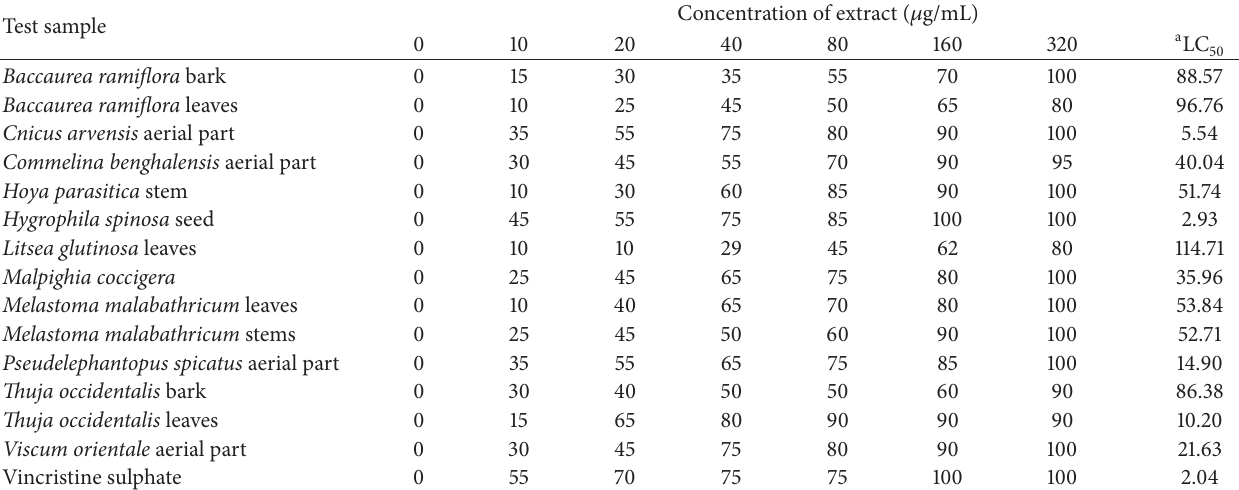
Table 4: Cytotoxicity of the fourteen extracts of eleven